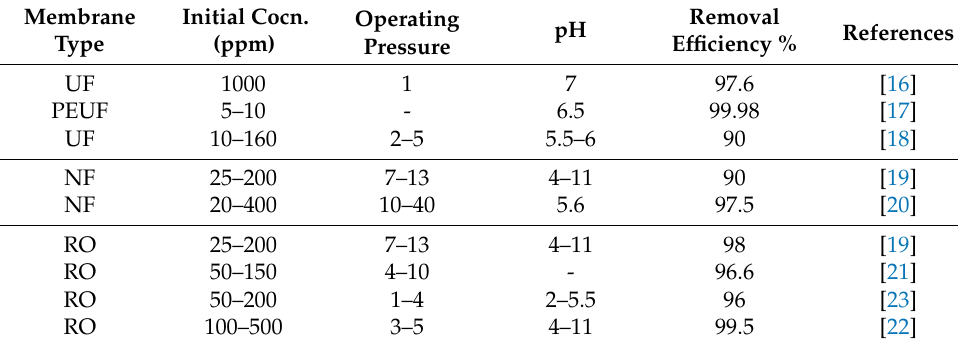
Table 1. Summary of studies on copper (II) ions removal using membrane